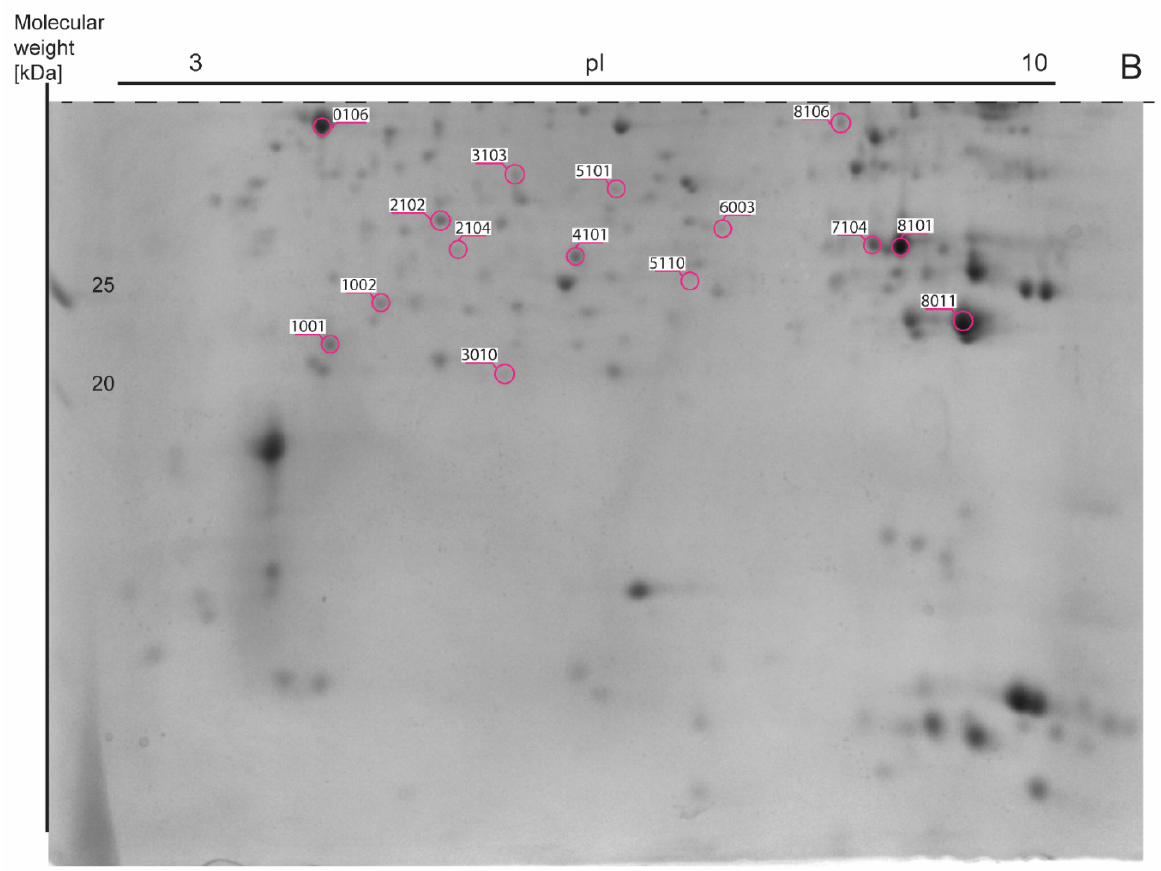
Figure 5. Part B of Figure 3 (representative 2DE map of liver proteins stained with Coomassie Brilliant Blue G-250). Spot numbers (SSP) and areas of differential spots in the figure correspond to the SSP number in Table